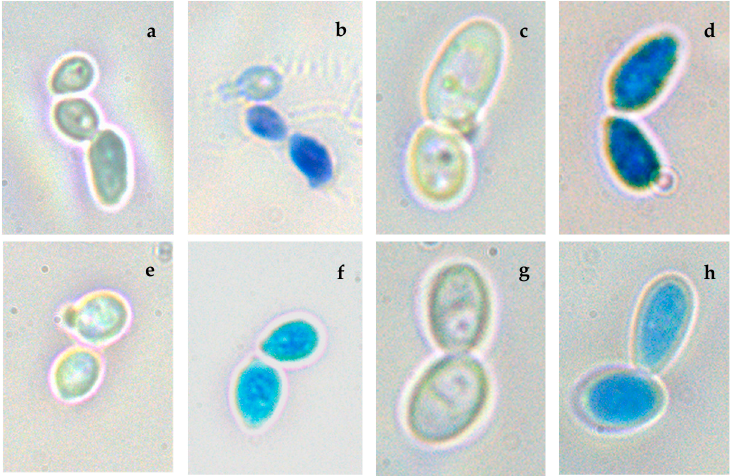
Figure 5. Microscopic observation (100×), of C. tropicalis (ORL21 and ORL20) and C. albicans (ORL08 and ORL3) before and after treatment with REO using Evans blue staining: ( a , c , e , g ) untreated controls and ( b , d , f , h ) cells treated with REO (8.2 µg/mL).